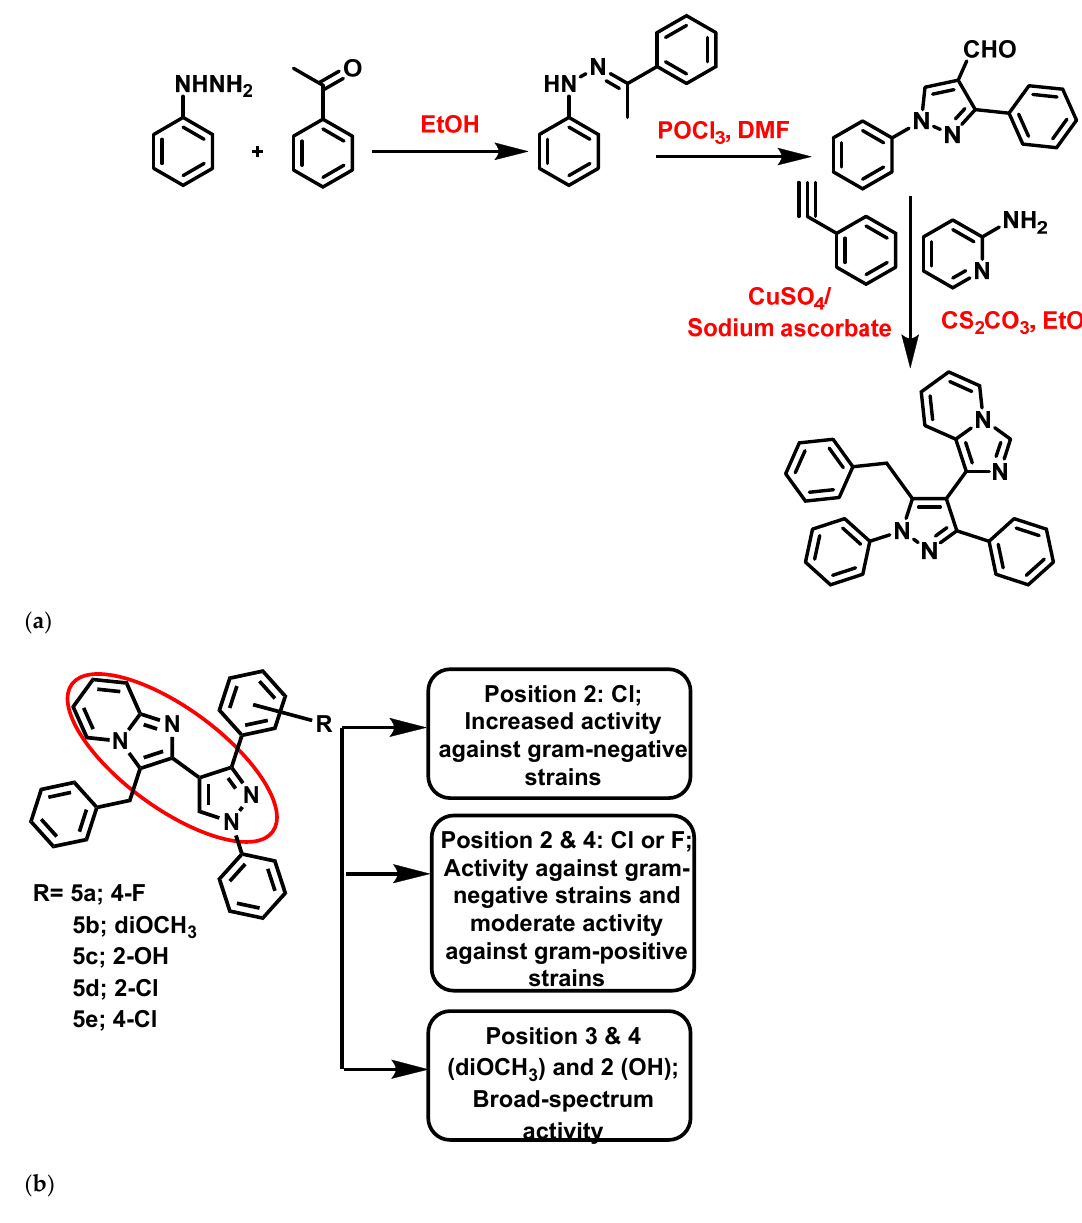
Figure 6. ( a ) Synthetic scheme of pyrazole-imidazo [1,2-a]pyridine derivatives. Signatures of com- pounds according to Ebenezer et al., 2019 [60]. ( b ) Pyrazolo-imidazopyridine molecular conjugates. Signatures of compounds according Ebenezer et al., 2019 [60]. At the same time Salhi et al., 2019 [61], reported dihydro ‐ IZPs as potential antibacte ‐